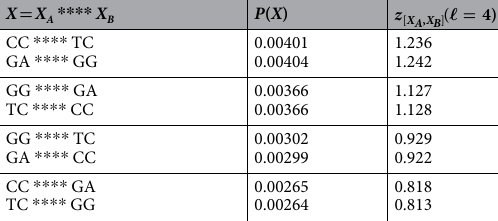
Table 1. Chargaff symmetric observables appear with similar frequency in the human chromosome 1. Each line contains an observable X constructed combining oligonucleotides α 1 α 2 … α 8 where α 1 α 2 equal to X A , α 3 α 4 α 5 α 6 are arbitrary (any in { A , C , T , G }), and α 7 α 8 equal to X B . Observables related by the extended Chargaff symmetry (3) appear on top of each other (separated by an horizontal line). The frequency of each observable P ( X ) was computed using Eq. (1) and the normalized version (cross correlation) z ( 4)  = using Eq. X X [ , ] A B